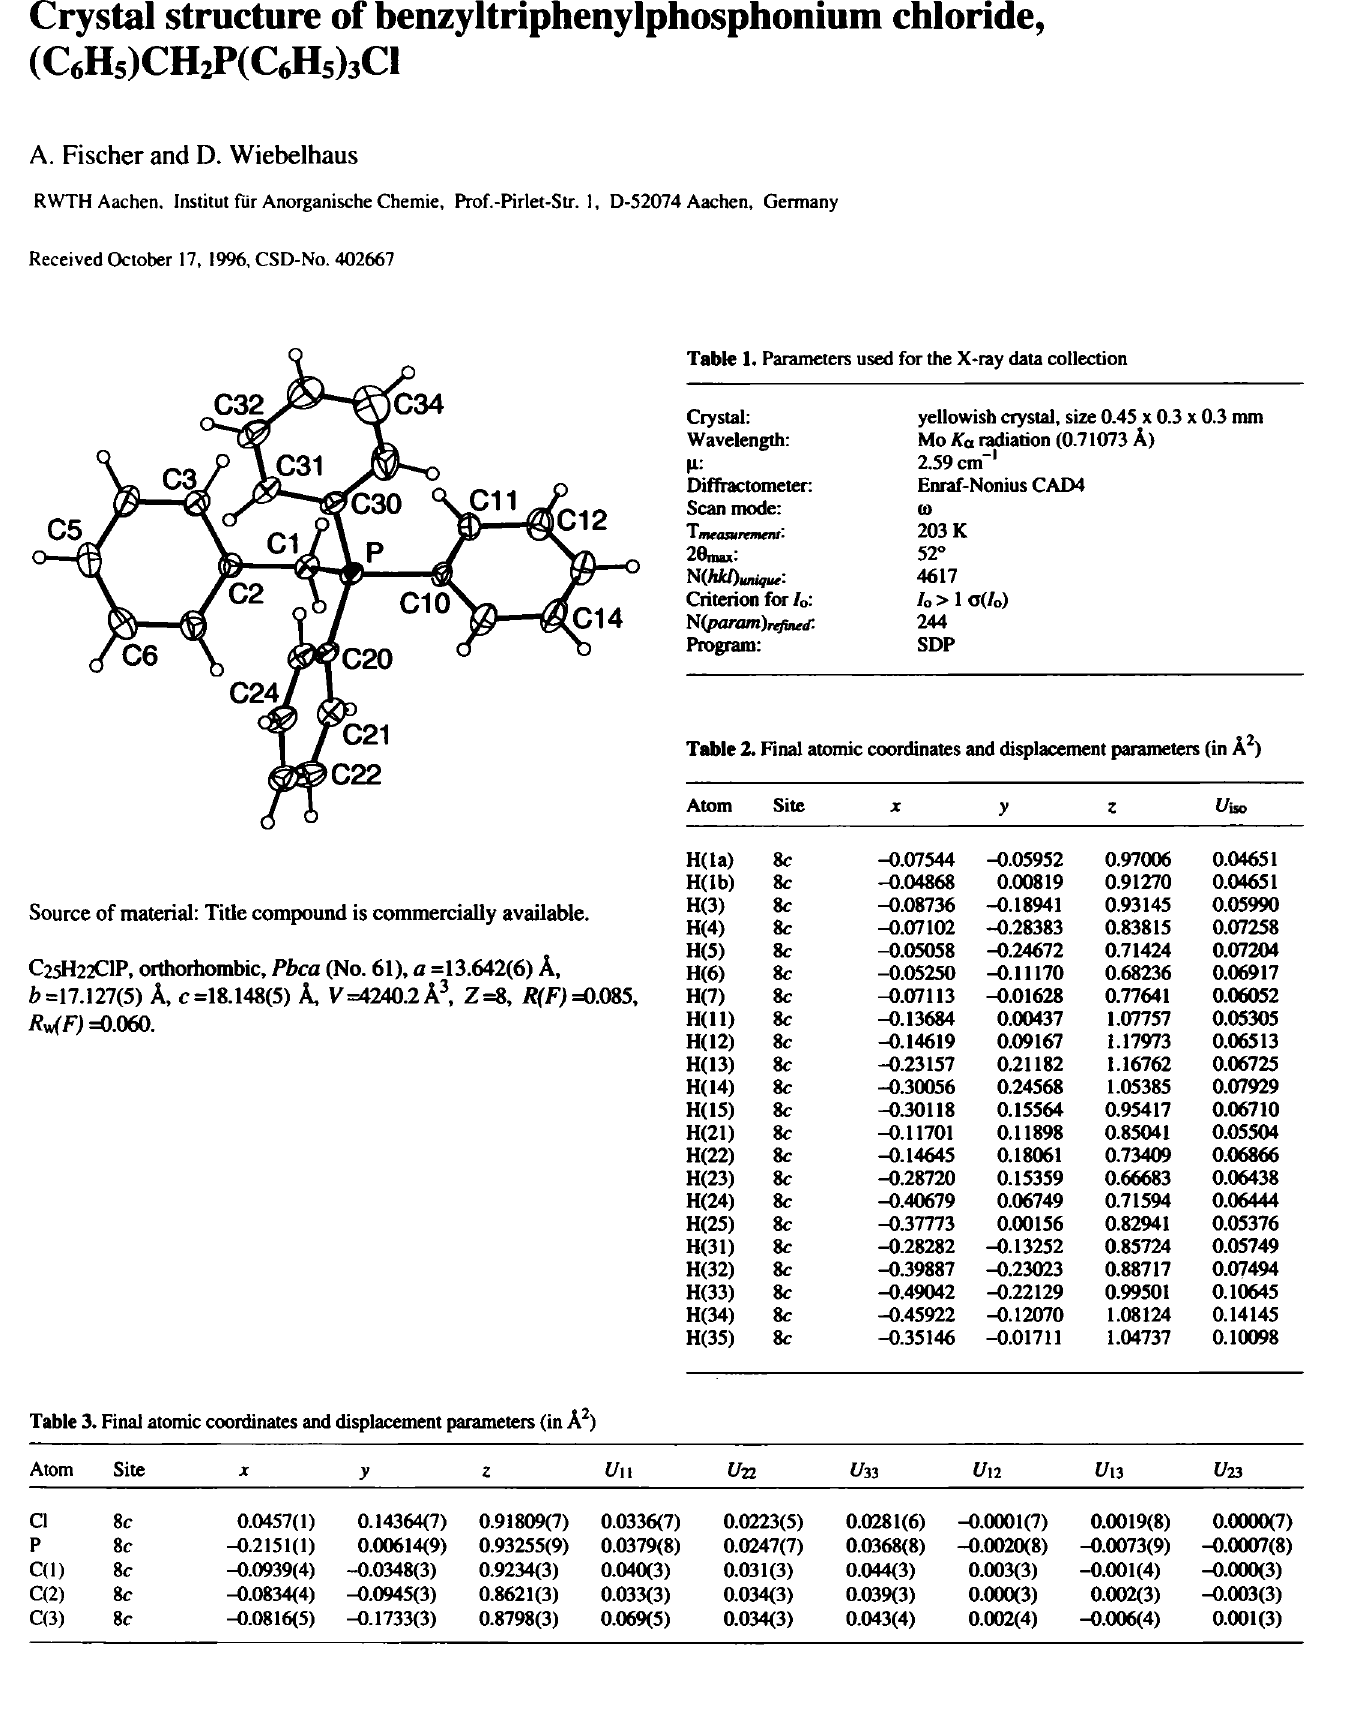
Table 1. Parameters used for the X-ray data collection